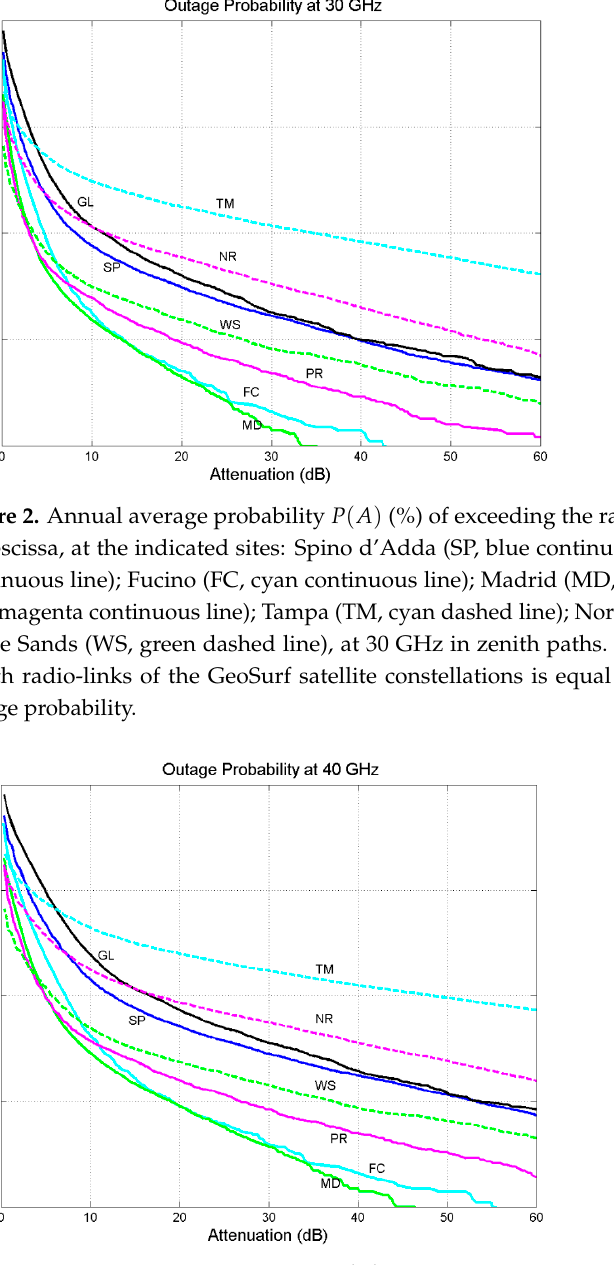
Figure 3. Annual average probability P ( A ) (%) of exceeding the rain attenuation A (dB) indicated in abscissa, at the indicated sites: Spino d’Adda (SP, blue continuous line); Gera Lario (GL, black continuous line); Fucino (FC, cyan continuous line); Madrid (MD, green continuous line); Prague (PR, magenta continuous line); Tampa (TM, cyan dashed line); Norman (NR, magenta dashed line); White Sands (WS, green dashed line), at 40 GHz in zenith paths. When the power margin in the zenith radio-links of the GeoSurf satellite constellations is equal to A (dB), P ( A ) represents the outage